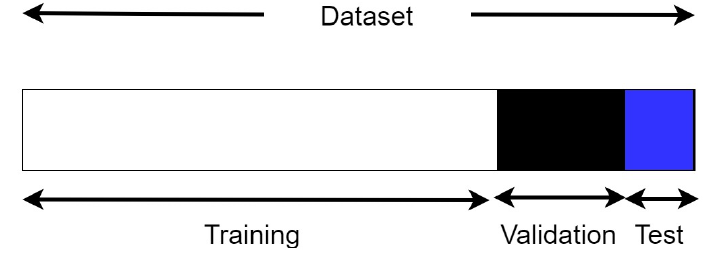
Figure 7. Data set